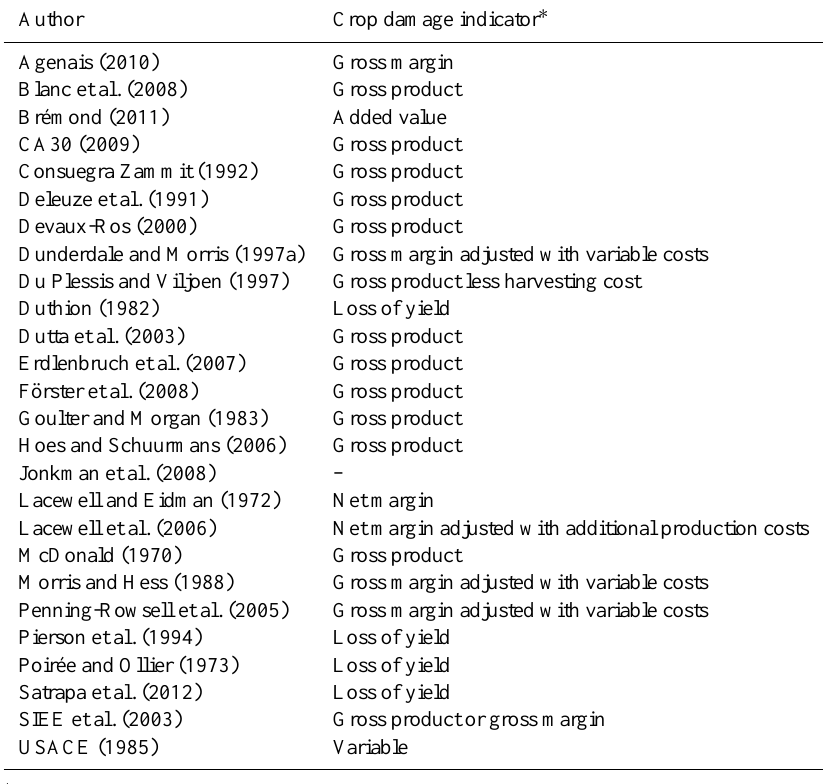
Table 5. Economic indicators used for crop damage in the studies